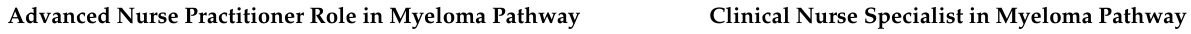
Table 1. Specific differences between advanced nurse practitioner and specialist nurse practitioner roles, with reference to the patient with